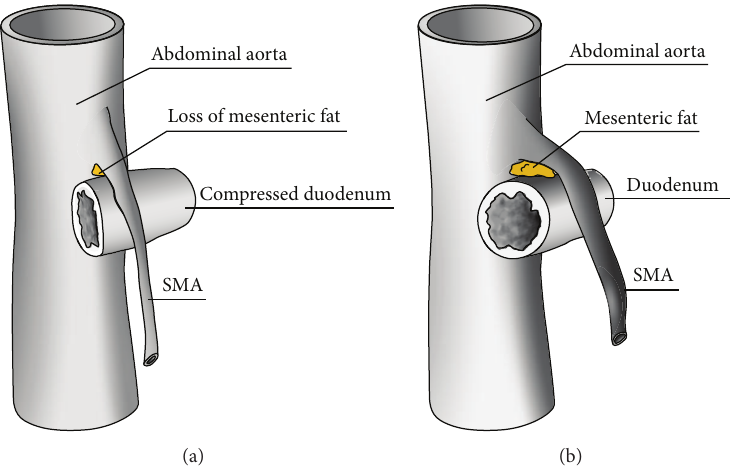
Figure 1: A schematic view of the aorta, SMA, and third portion of the duodenum. (a) Loss of mesenteric fat producing an acute angle between aorta and SMA and compression of the duodenum. (b) Presence of mesenteric fat and a normal angle between aorta and SMA.